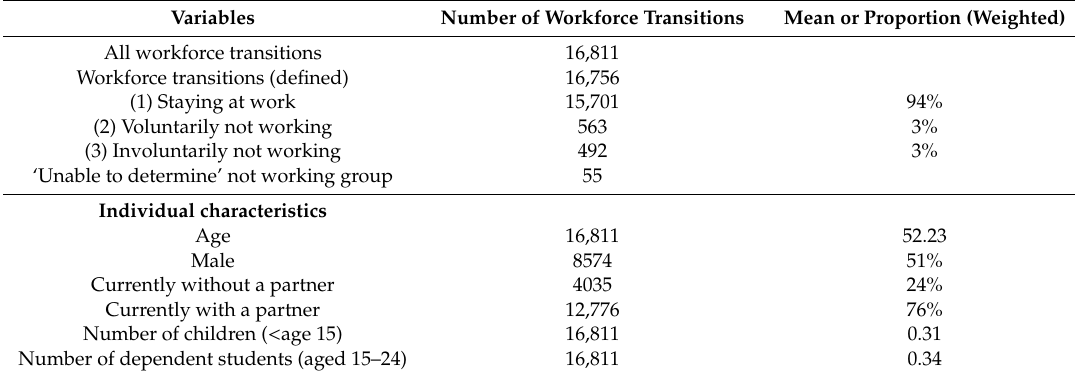
Table 2. Individual characteristics and work conditions associated with workforce